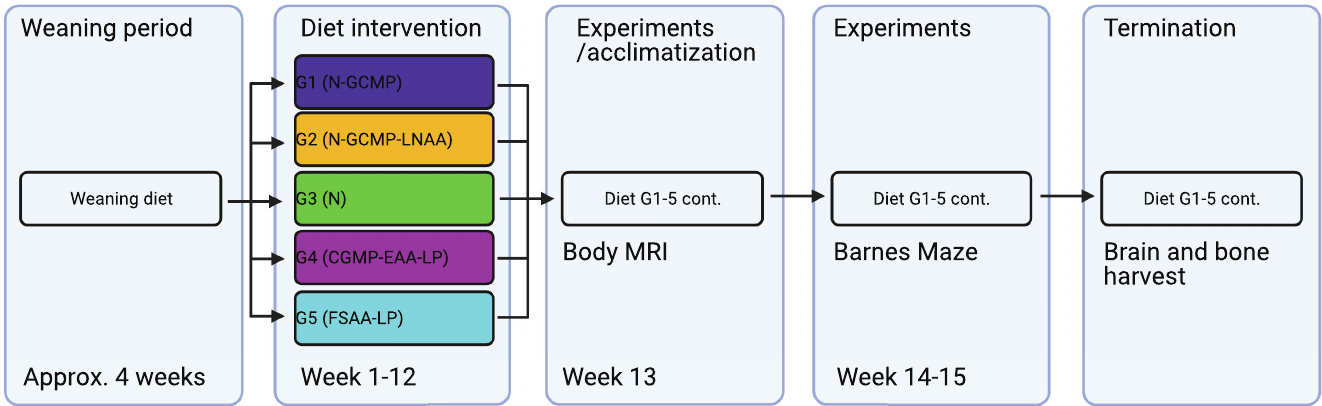
Fig 1. Timeline of the study design (weeks refer to the week of diet treatment, which continuous from week 1 until week 15.